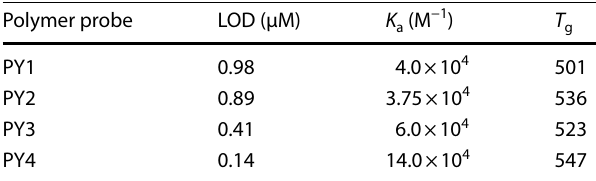
and K for polymeric probes before and after the Table 2 LOD, T g a probe was combined with Fe 3+ Polymer